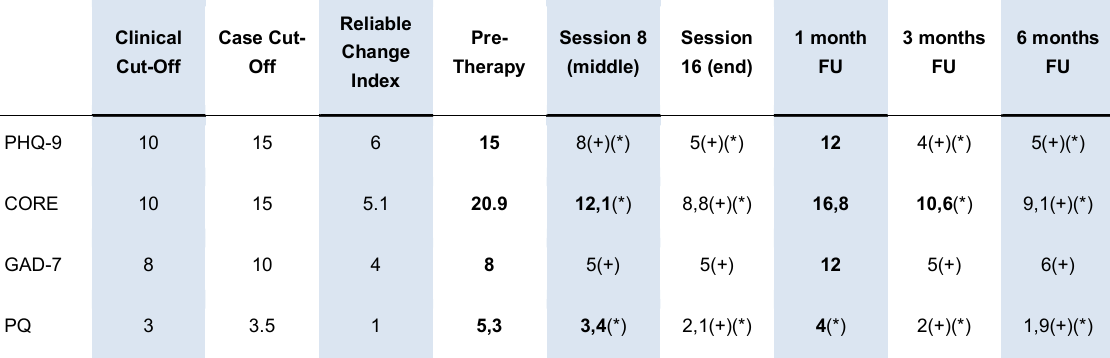
Table 2: Sara’s Quantitative Outcome Data Note. Values in bold are within clinical range; + indicates clinically significant change (CS). * indicates reliable change (RCI). CORE = Clinical Outcomes in Routine Evaluation-Outcome Measure (Evans et al., 2000). PHQ-9 Patient Health Questionnaire 9-item for depression (Spitzer, Kroenke & Williams, 1999) GAD-7 = Generalized Anxiety Disorder 7-item (Spitzer, Kroenke, Williams, & Löwe, 2006). PQ = Personal Questionnaire (Elliott, Shapiro, & Mack, 1999). HAM-D = Hamilton Depression Rating Scale (Hamilton, 1960). FU = follow-up.